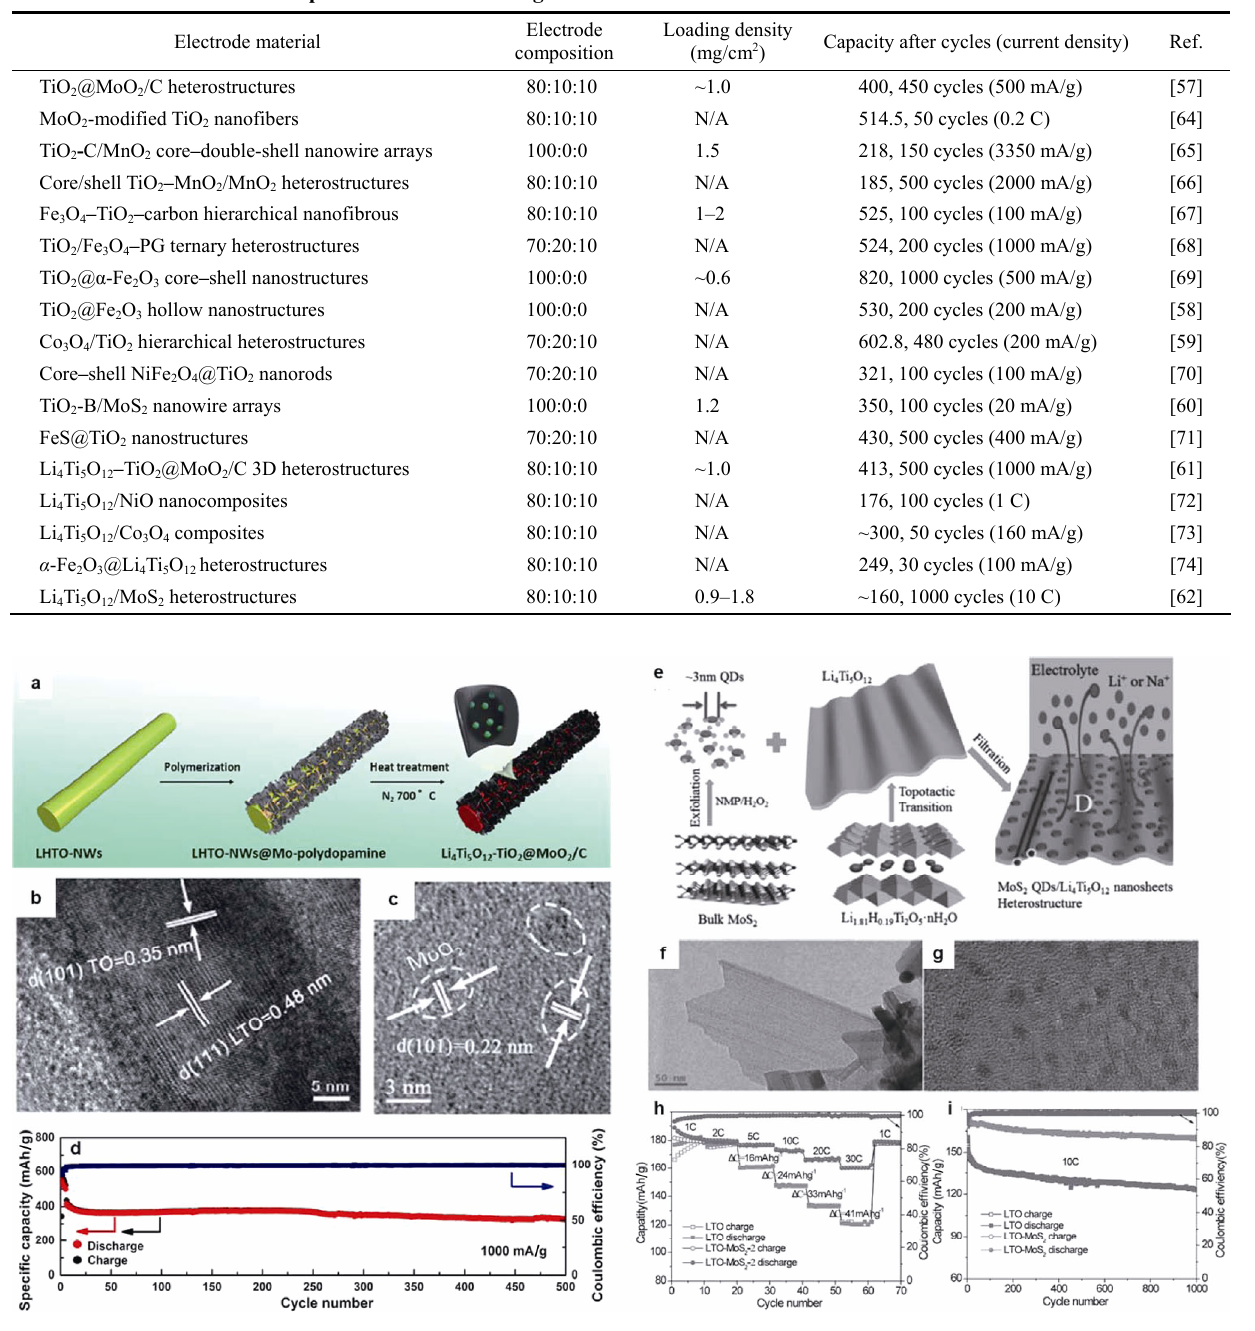
Fig. 6 Recent progress of Li 4 Ti 5 O 12 hybrid nanocomposites with conversion-type anodes. (a) Schematic preparation process, (b, c) HRTEM images, and (d) cycling performance of Li 4 Ti 5 O 12 –TiO 2 @MoO 2 /C nanocomposite. Reproduced with permission from Ref. [61], © The Royal Society of Chemistry 2017. (e) Schematic preparation process, (f, g) HRTEM images, (h) rate performance, and (i) cycling performances of MoS 2 QDs/Li 4 Ti 5 O 12 nanosheet nanostructure. Reproduced with permission from Ref. [62], © John Wiley and Sons